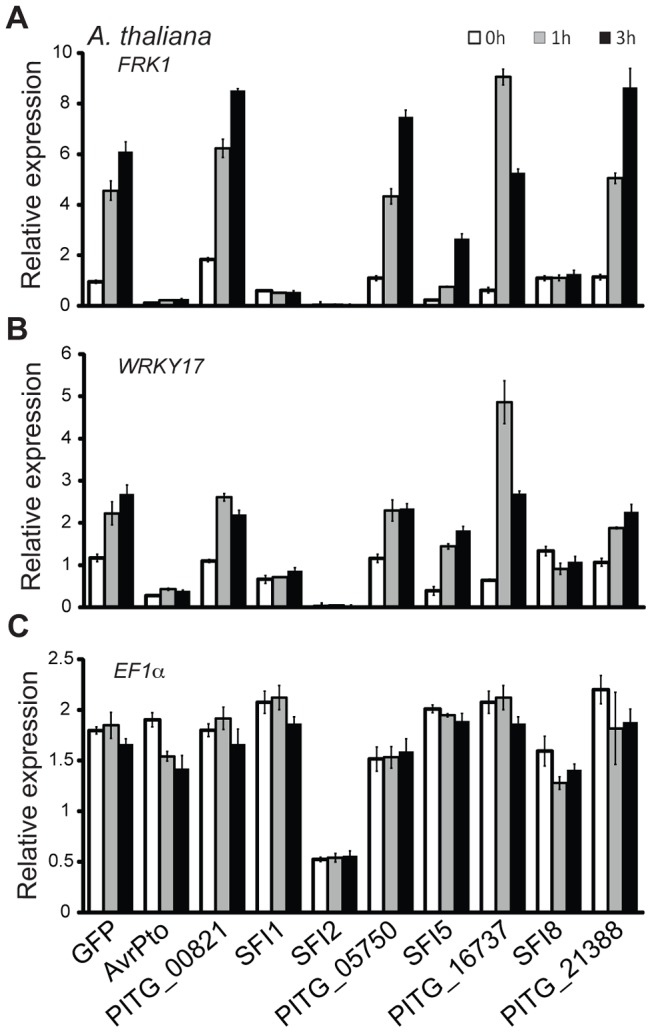
Transcriptional profiling of MAMP-inducible genes in A. thaliana protoplasts transfected with SFI effector constructs.(A–C) Relative gene expression for the flg22-inducible genes FRK1 and WRKY17 (A, B) and the housekeeping gene EF1α (C) was assessed by quantitative real-time polymerase chain reaction (qRT-PCR) 0, 1 and 3 h after protoplasts were exposed to flg22. Transcript levels of the analyzed genes were normalized to the levels of the Actin transcript. GFP was used as a negative and AvrPto as a positive control for suppression of gene expression. One representative independent experiment out of four is plotted. Data is presented as mean ± SEM from three technical replicates.